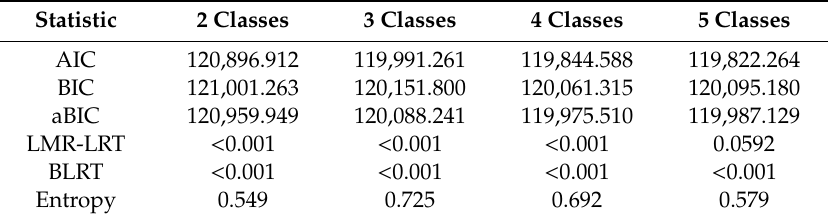
Table 2. Model fit statistics for each of the fitted latent class analysis models.